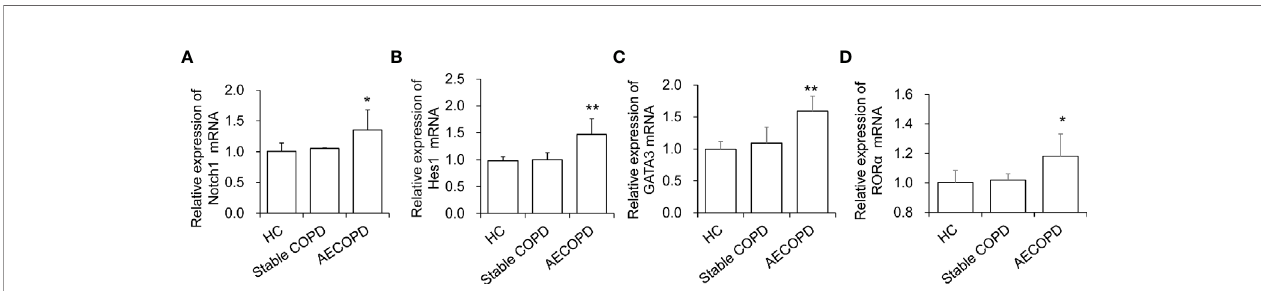
FIGURE 2 | Levels of ILC2 related transcription factors in different groups. The mRNA levels of (A) Notch1 , (B) Hes1 , (C) GATA3 and (D) ROR a were tested by real-time PCR. Data were normalized to control group and represented as mean ± SEM. n=50. * P < 0.05, ** P < 0.01 compared with control group.